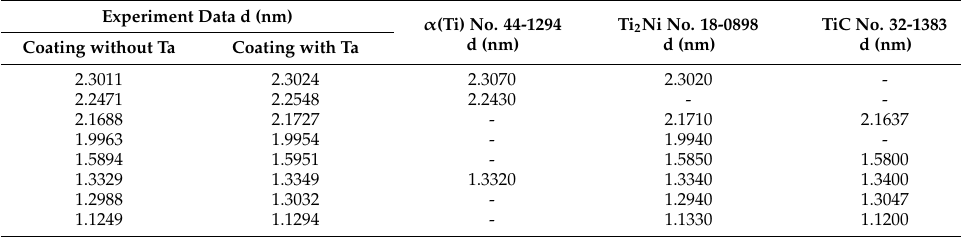
Figure 1. X-ray diffraction patterns of the coatings. Table 1. XRD data for coating without and with Ta.